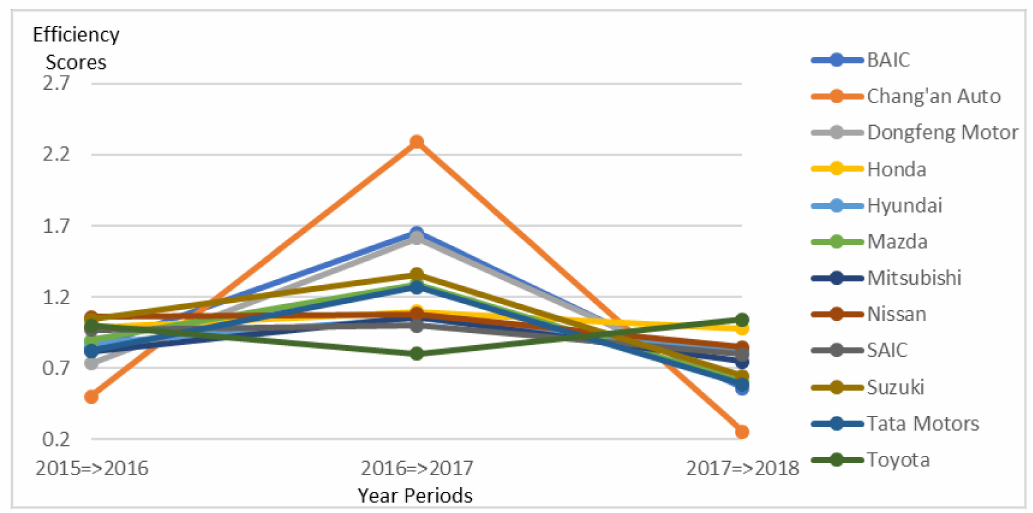
Figure 11. Total-factor-productivity change of Asian